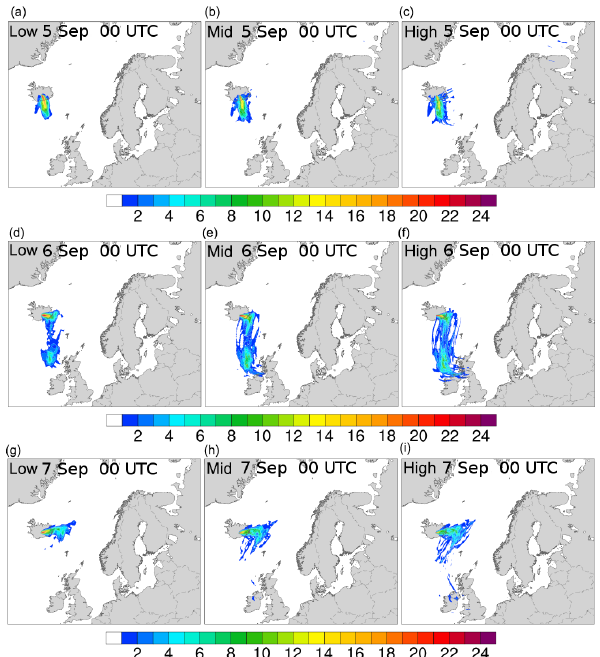
Figure 3. The same as Fig. 2, counting ensemble members locally exceeding a 50DU